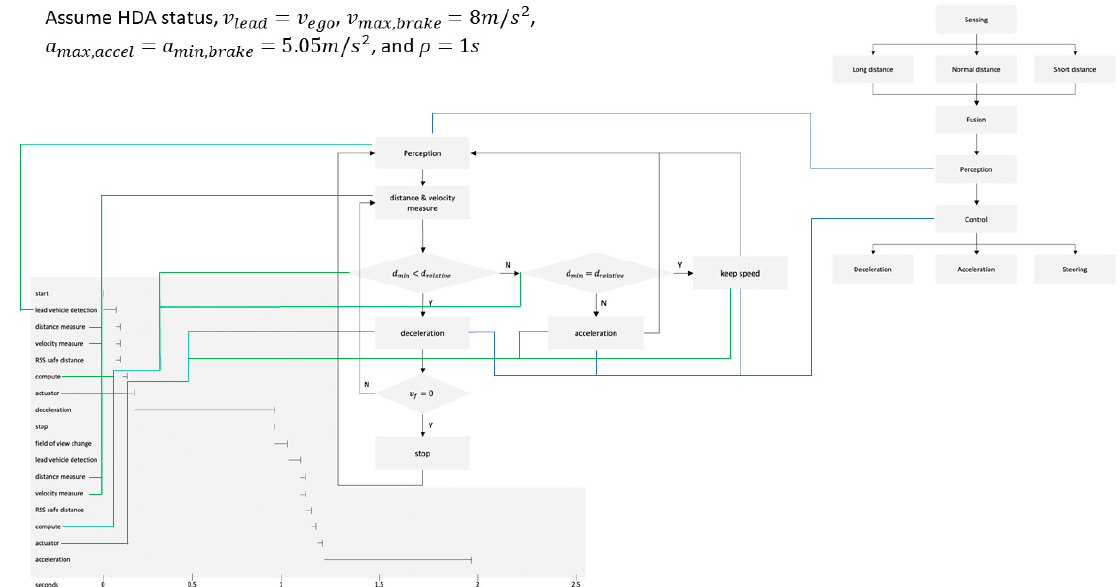
Figure 6. Timeline analysis of response time for each component during HDA.